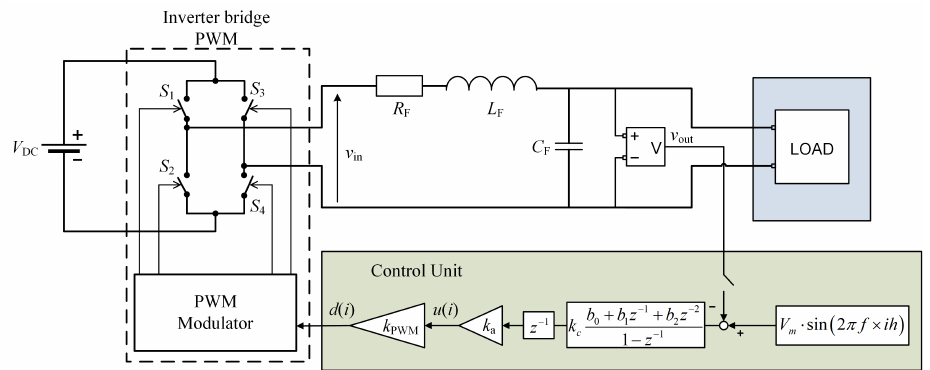
Figure 3. Schematic diagram of a PWM based simulation model of the discrete-time control